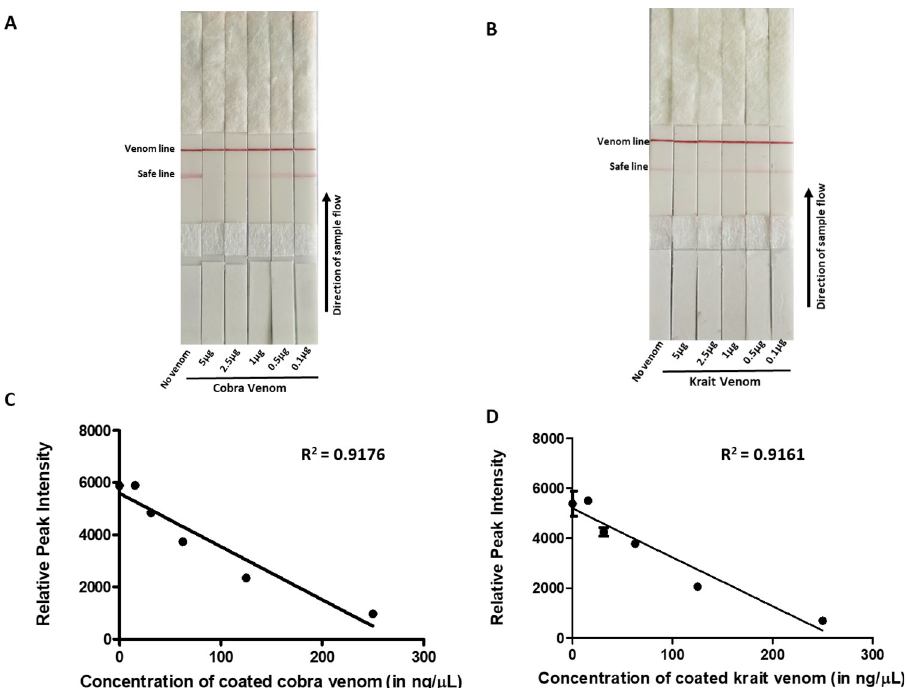
Fig 6. Detection of venoms of N . naja and B . caeruleus by the kit in spiked serum samples. Panel A and B . Varying amount of venom samples spiked into serum were applied onto the strip of the LFA kit and the disappearance of safe line was noted. Panel C and D . The data points obtained from densitometric analysis of safe line were fit in a straight line for a non–linear regression curve using effective venom concentration to determine the limit of quantitation.